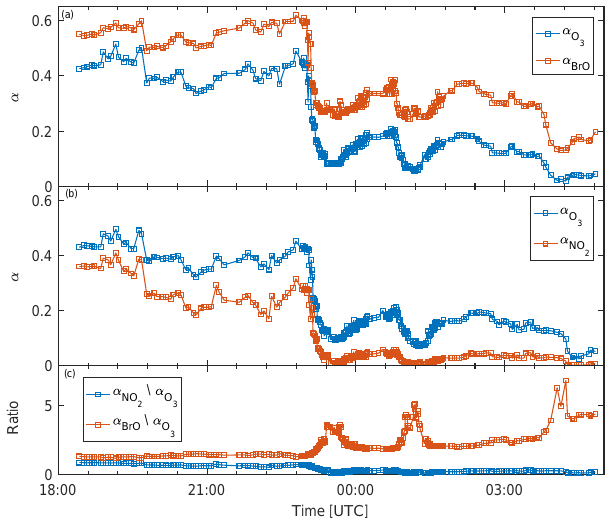
Figure 11. α factors (Eqs. 11 and 13) for measurements of O 3 and BrO in the UV spectral range (a) and O 3 and NO 2 in the VIS spec- tral range (b) (for the wavelength ranges see Table 2) for the sunlit part of SF3-2013 (14 February 2013). Panel (c) shows the ratio of the α factors in each wavelength